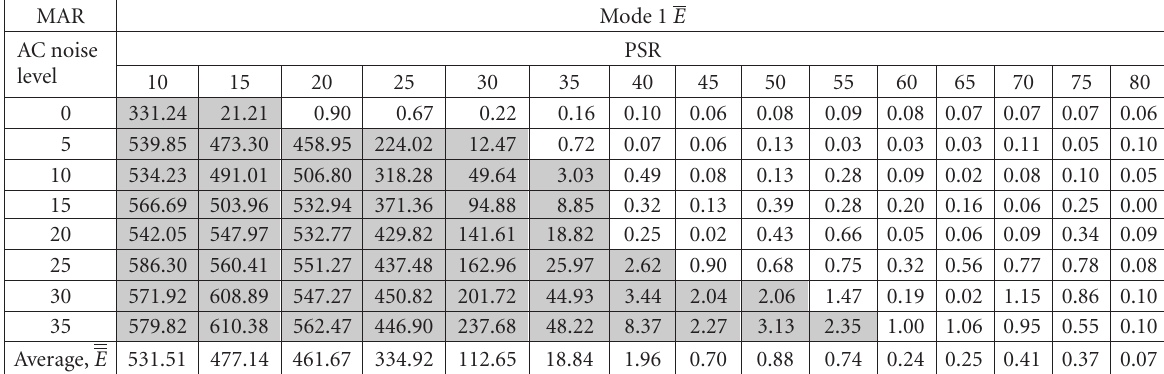
Table 3: MAR E results for mode 1 at for di ff erent noise level and PSR%.